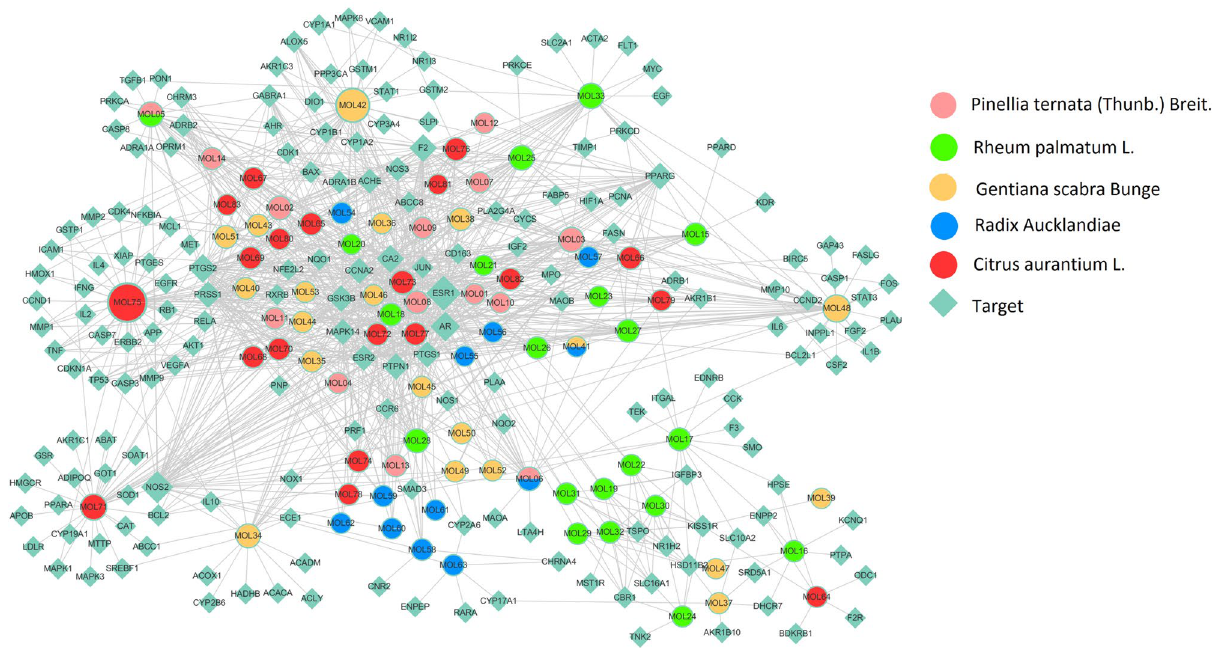
Figure 3. Compound-Target network. The olive green diamonds represented the potential targets. The other five colors represented the active molecules of five different herbs in PRGRC. If one circle had more than one color, it meant that this molecule exists in more than one herb. The larger the size of the circle, the greater the correlation between the target and the compound. Gray lines represented interactions between compounds and targets.